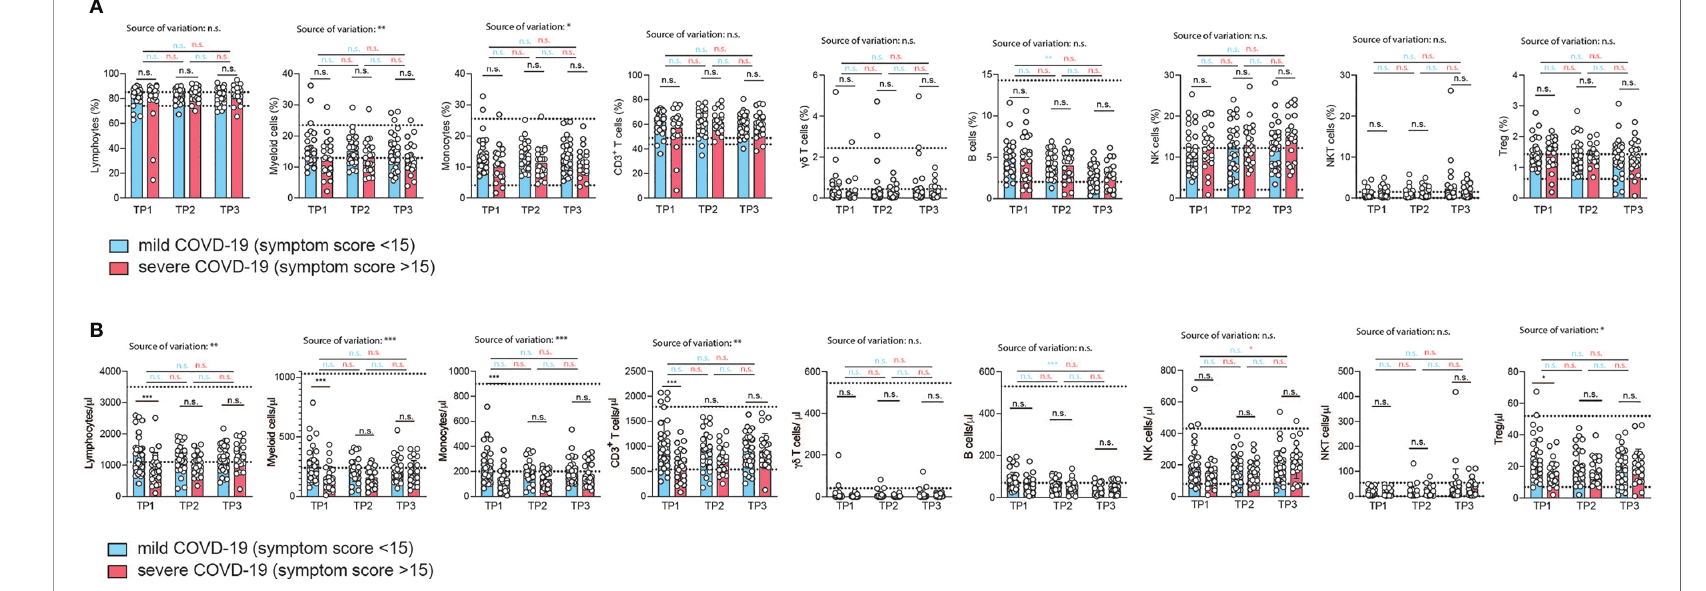
FIGURE 2 | Correlation of immunophenotypes with COVID-19 severity over time. (A, B) Flow cytometry of ex vivo isolated PBMC gated on the indicated cellular subpopulations. Each circle represents one patient. (A) relative proportions as determined by manual gating. (B) absolute cell numbers as determined by manual gating. 2way ANOVA tests with Holm-Sidak ’ s multiple comparisons tests were performed for comparison of mildly versus severely affected patients longitudinally. *P < 0.05, **P < 0.01, and ***P < 0.001, n.s., not signi fi cant. The dotted lines indicate the range of physiological variations of the respective cell